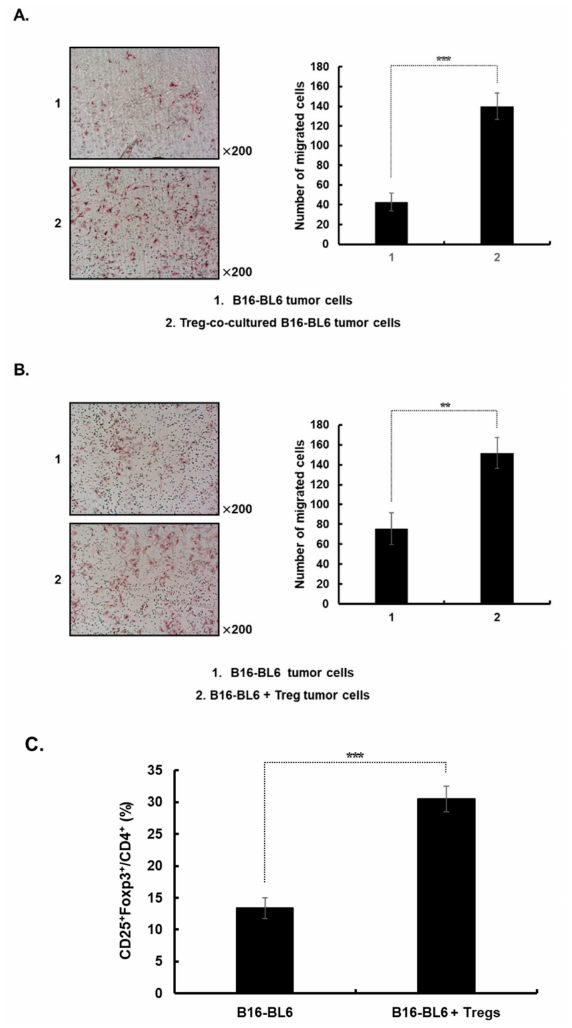
Figure 5. Increased migration of cancer cells and Tregs in both tumors established from Treg-co-cultured B16-BL6 cells or tumors injected with Tregs. To assess the e ff ect of Tregs on the migration of dissociated tumor cells, ( A ) B16-BL6 cells were co-cultured with Tregs for 72 h at co-culture ratios of 1:10 when inadherent Tregs were removed from culture by multiple washing steps. Subsequently, the cells were detached and 5 × 10 5 cells were injected subcutaneously into the right abdomen to establish a tumor or ( B ) subcutaneous tumors in the right abdomen were established using naïve B16-BL6 cells and subsequently injected intratumorally with Tregs (2 × 10 7 cells) three times every other day. The igration profile of cells dissociated from the B16-BL6 tumors was analyzed using a modified transwell migration chamber. The cells that had migrated to the lower filter surface were stained with H & E. The images are representatives of results from 3 independent experiments. Original magnification: × 200. Migrated cells were counted in three randomly selected fields. Data are shown as mean ± SD of results from three independent fields / well. *** p < 0.001 or ** p < 0.01. ( C ) Tumors were collected from mice injected with Tregs at 5 days after the final injection. The populations of Tregs in tumors from mice were analyzed by flow cytometry. Gating was for cluster of di ff erentiation (CD)4 + T cells and analysis for CD25 + and Foxp3 + cells. The data are representative of three independent experiments performed in triplicate. Data points are mean ± SD ( n = 3 per group). *** p <